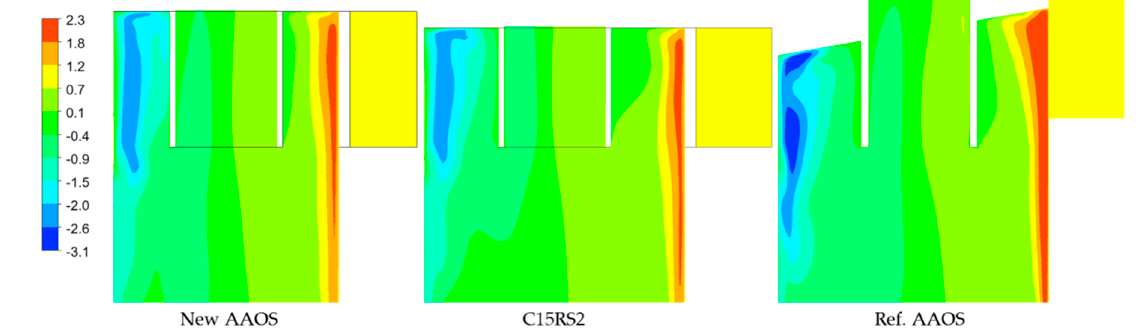
Figure 16. Time-averaged tangential velocity—plane 1 − 1.